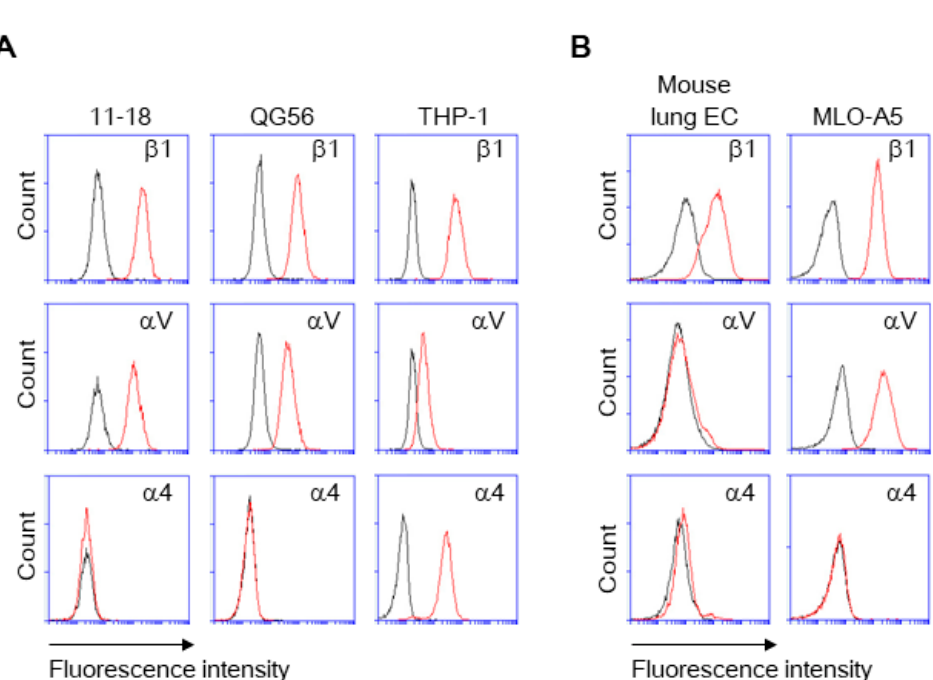
Figure 2. Expression of β 1, α V, and α 4 integrins on cells. The cells were stained with the fluores- cently labeled monoclonal antibodies (mAbs) to integrins. The integrin expression was analyzed by using flow cytometry for human ( A ) and mouse ( B ) cells. Histograms indicate the expression of integrins indicated. Data are representative of three separate experiments. Red lines, mAb; black lines, isotype IgG.